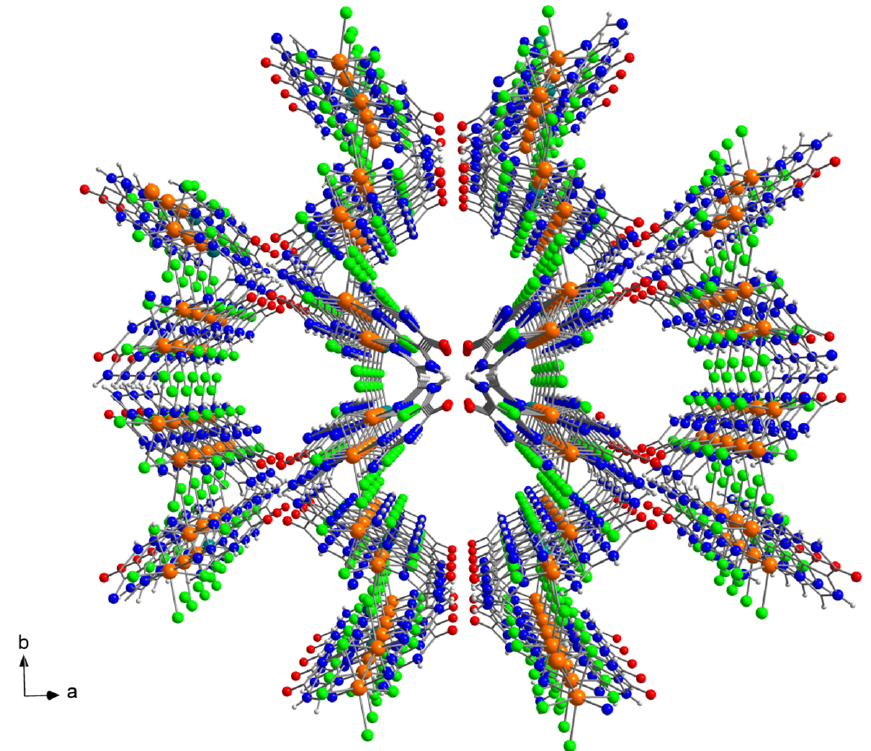
Figure 3. View along the crystallographic a axis of a fragment of the crystal packing of 1 . H-bonding interactions between O atoms and N-H groups of adjacent [{Ru(µ-Cl)(µ-gua)} 2 Cl 4 ] units are shown as red-dashed lines. Water molecules have been omitted for clarity.